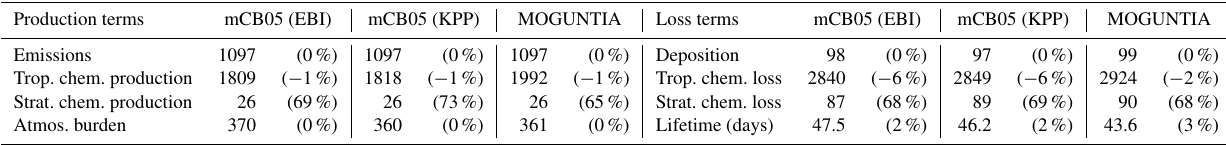
Table 6. Global budgets and burden (Tg(CO)) of CO for the year 2006 (Tg(CO)yr − 1 ) using the 150ppb O 3 mixing ratio to define the tropopause level. In parentheses, the relative differences using the 100ppb O 3 mixing ratios are also presented, calculated with reference to the 150ppb O 3 tropopause level